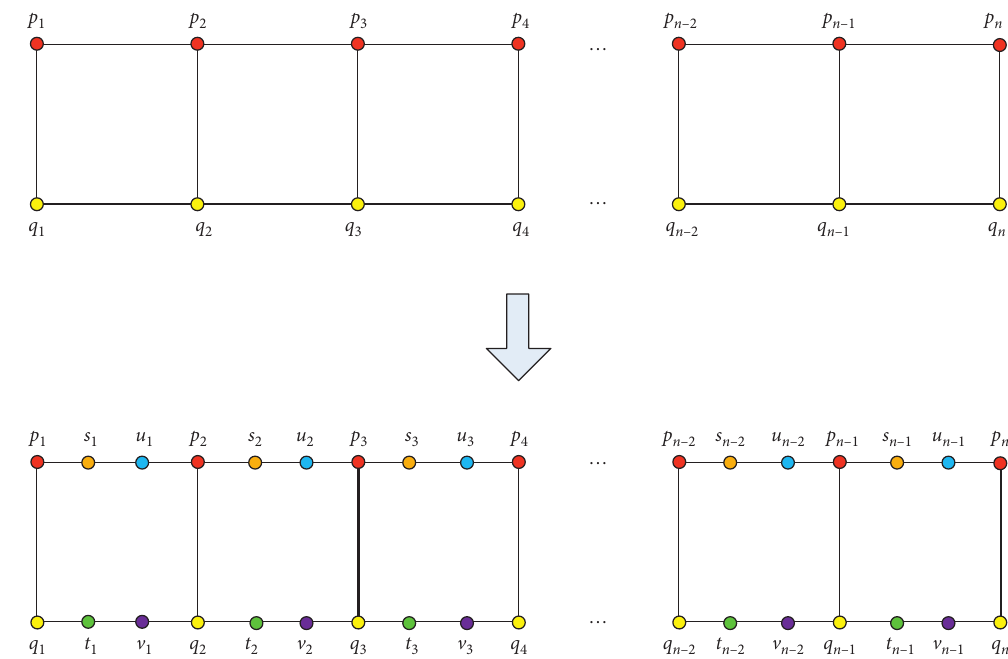
Figure 1: Linear polyomino network Q